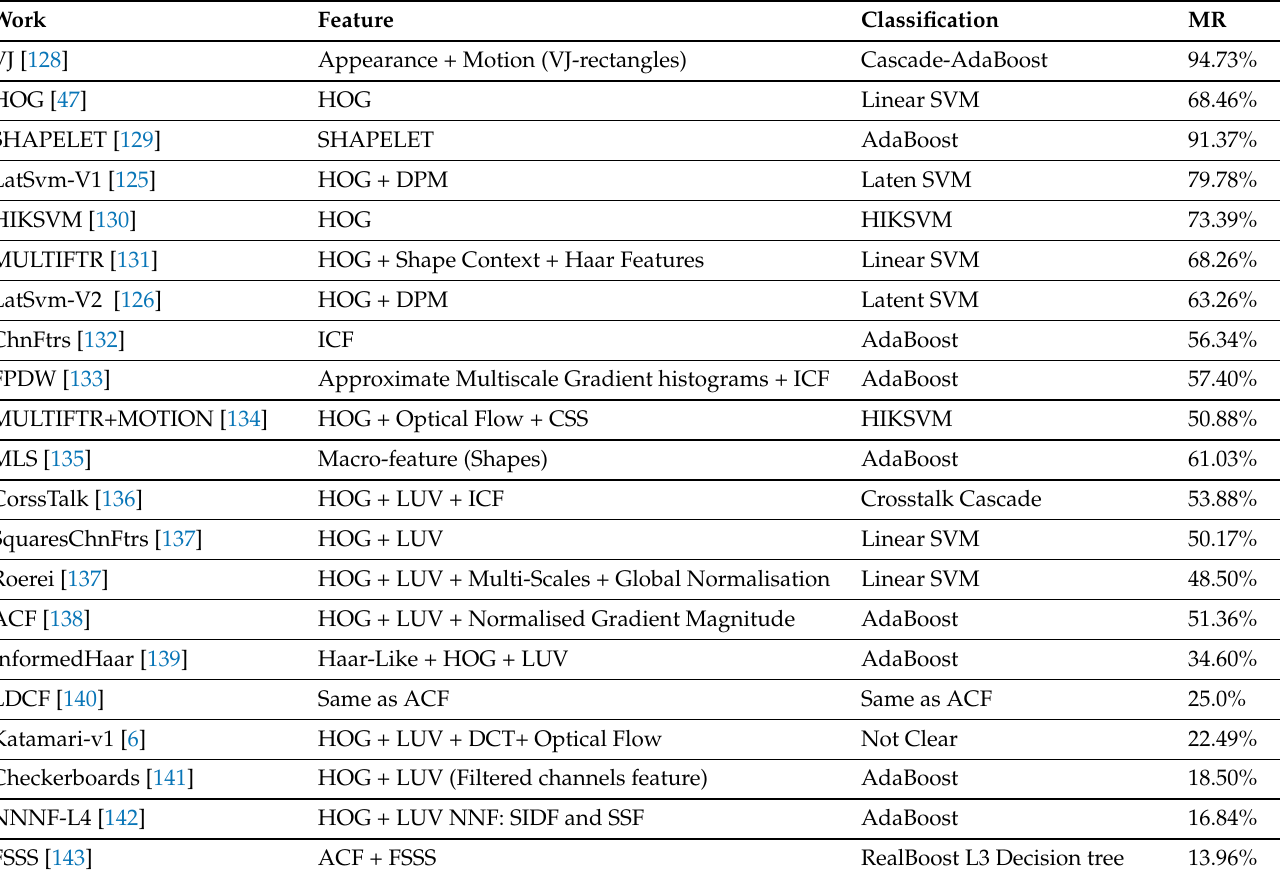
Table 5. Relevant works for pedestrian detection using traditional